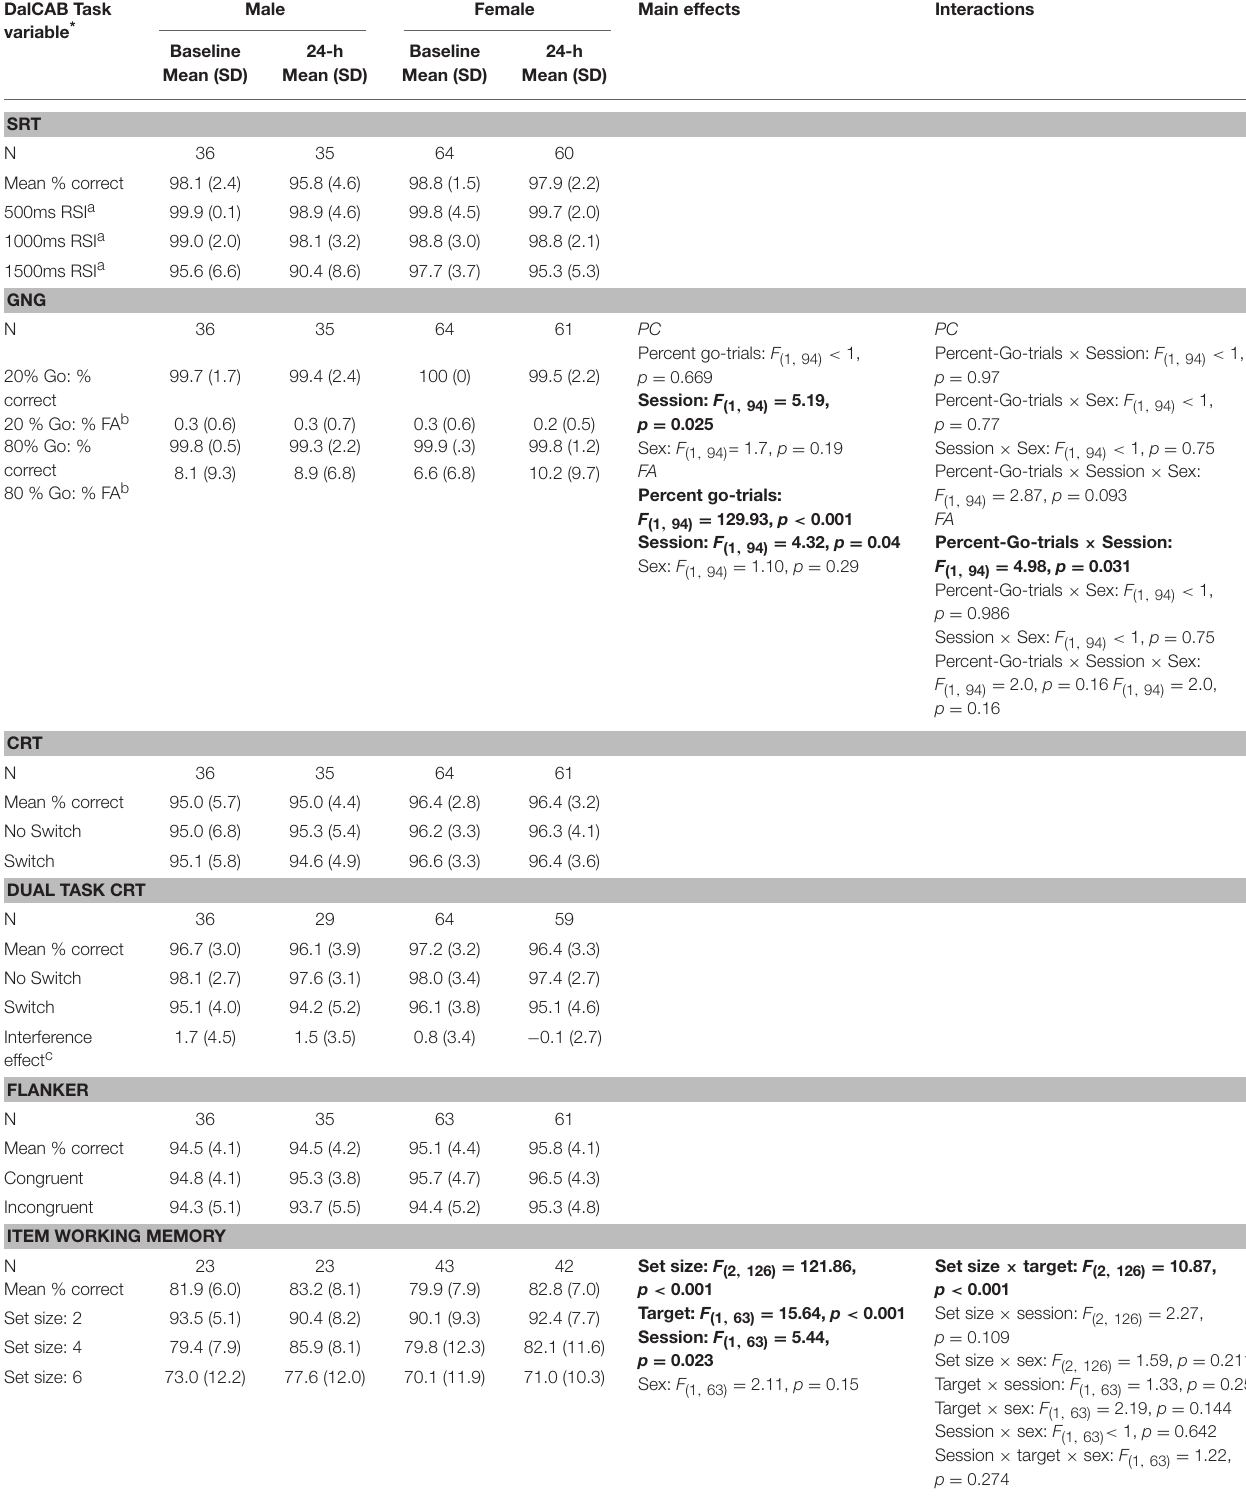
TABLE 4 | Mean accuracy for independent variables on the DalCAB tasks for groups of male and female participants at the baseline and 24-h testing sessions. DalCAB Task Male Female Main effects variable *